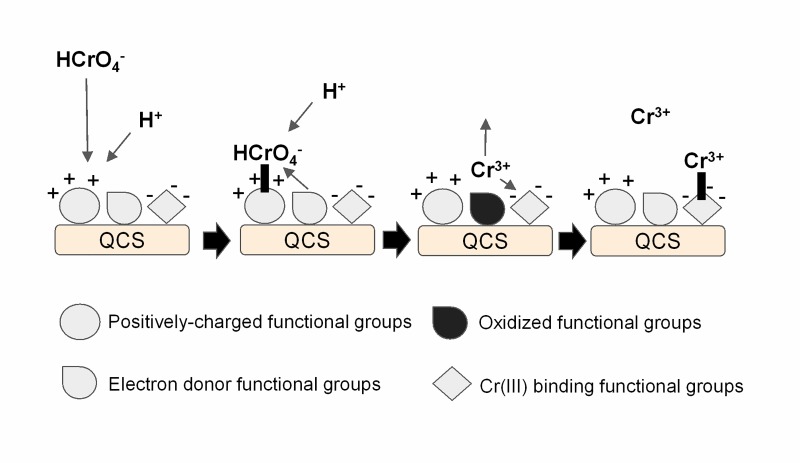
Proposed mechanism for Cr(VI) removal by QCS [40].